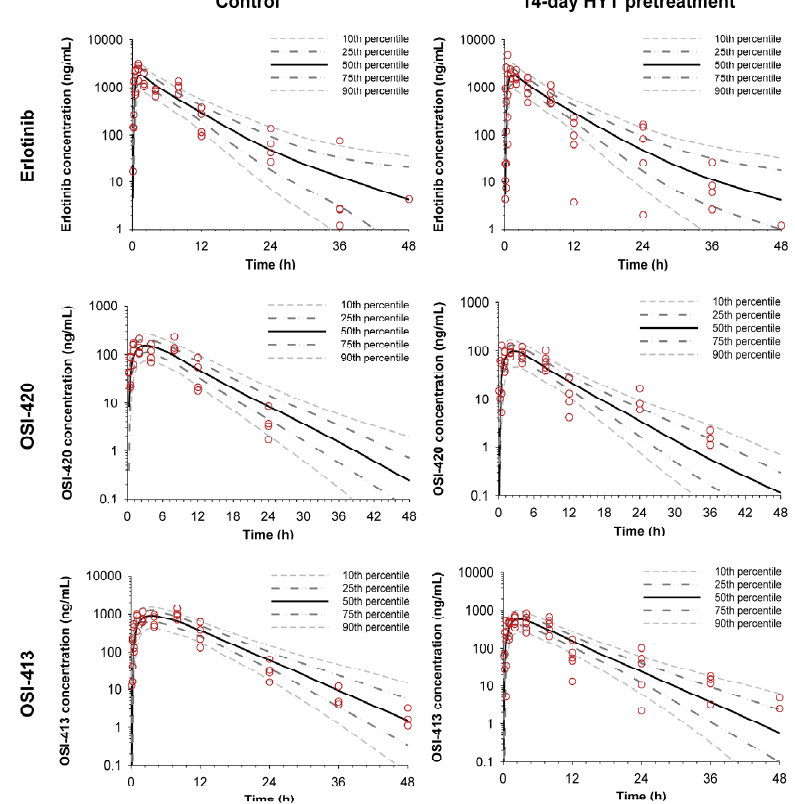
Figure 4. Visual predictive check plots of the population pharmacokinetic model for erlotinib ( upper ), OSI-420 ( middle ), and OSI-413 ( lower ). The observed plasma concentration of erlotinib, OSI-420, and OSI-413 in control and 14-day HYT pretreatment group (open circles) are shown with the lines representing the 10th, 25th, 50th, 75th, and 90th percentiles of the population predictions.